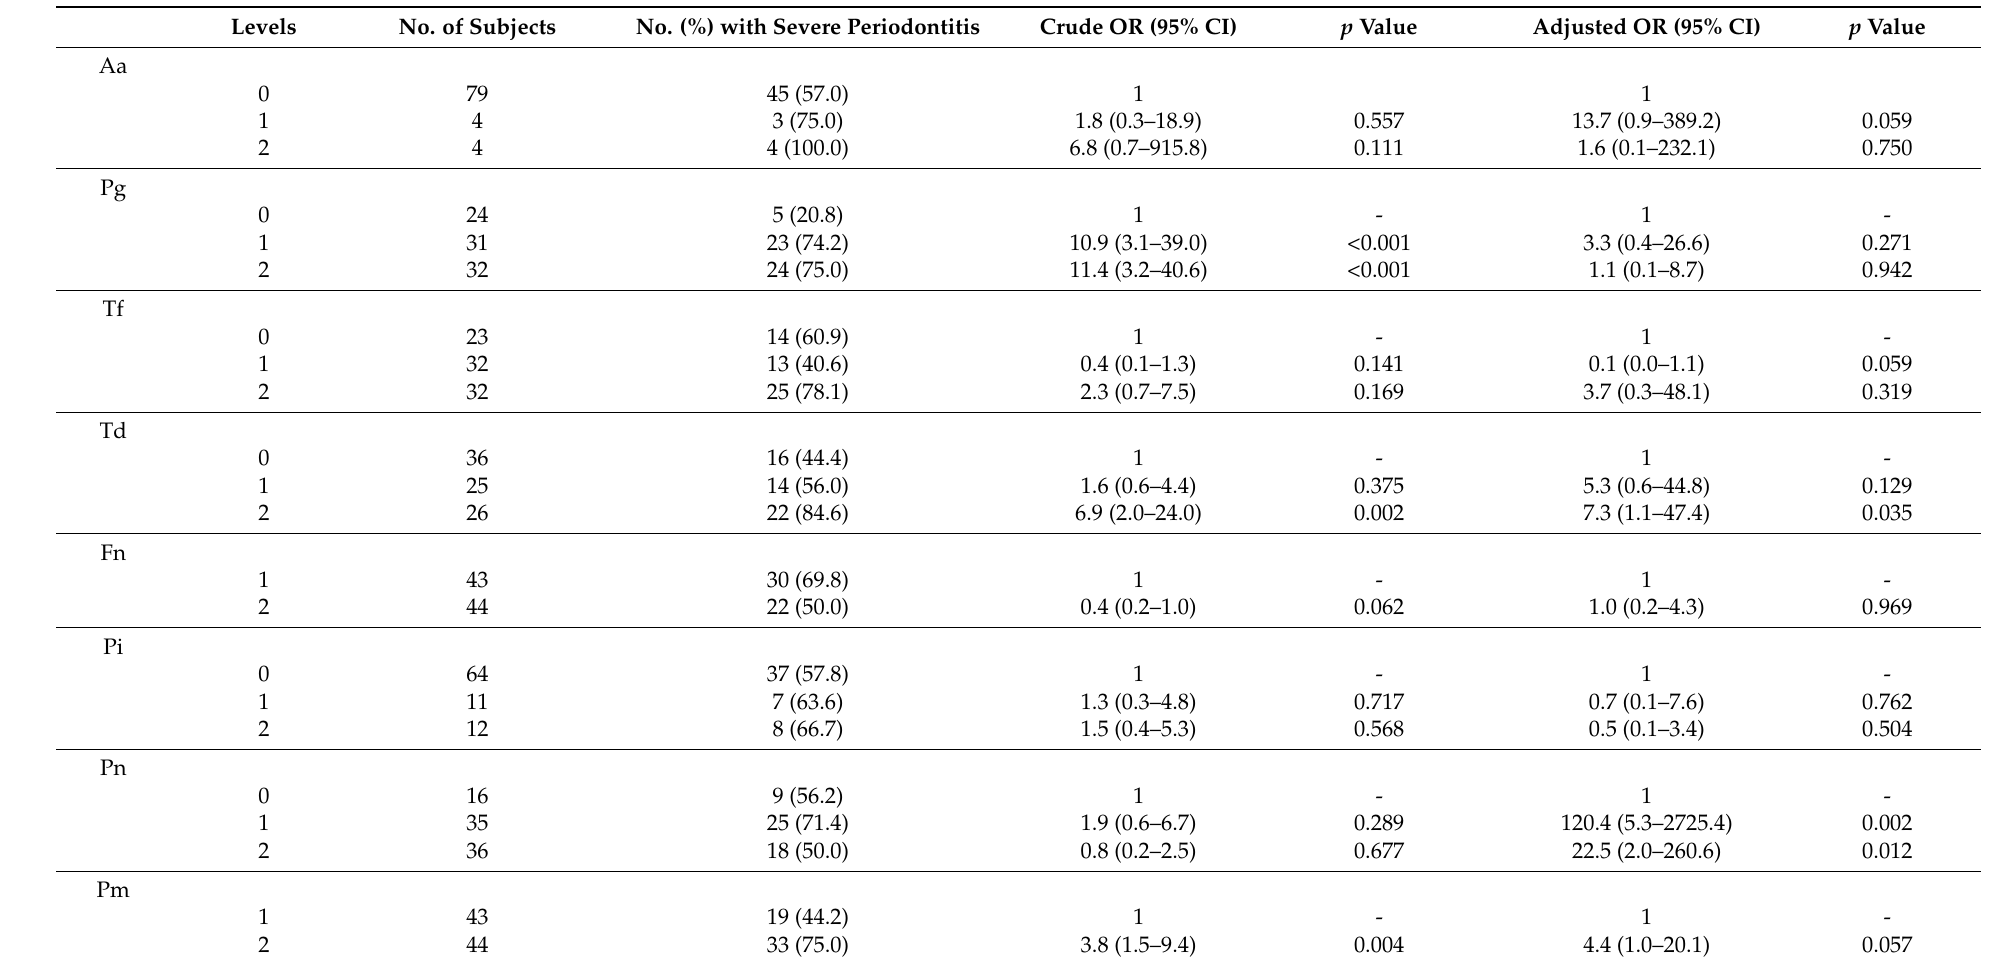
Table 7. Association of severe periodontitis according to levels of target